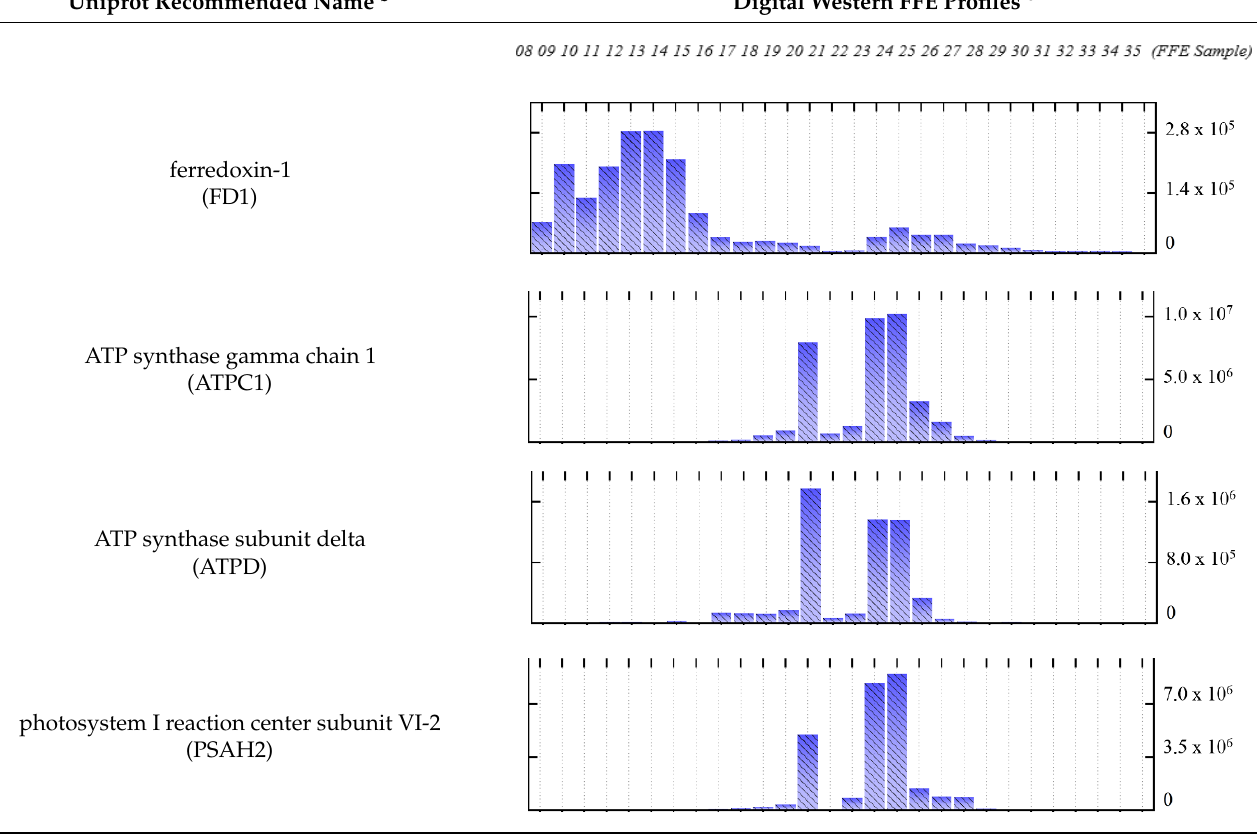
Table 9. Protein profile of ferredoxin compared with three other thylakoid markers a .